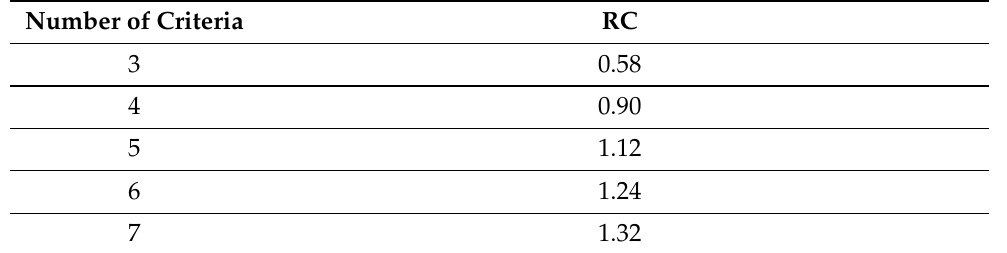
Table 3. Random consistency